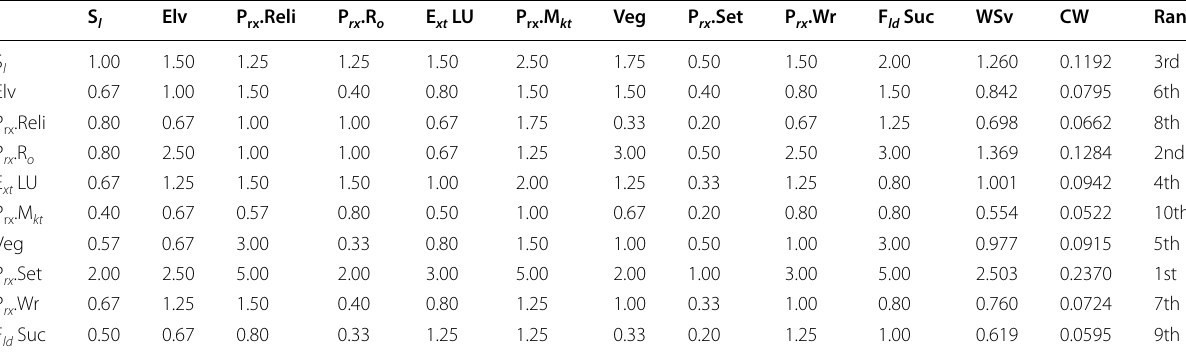
Table 6 Pairwise comparison matrix of UGS contributing